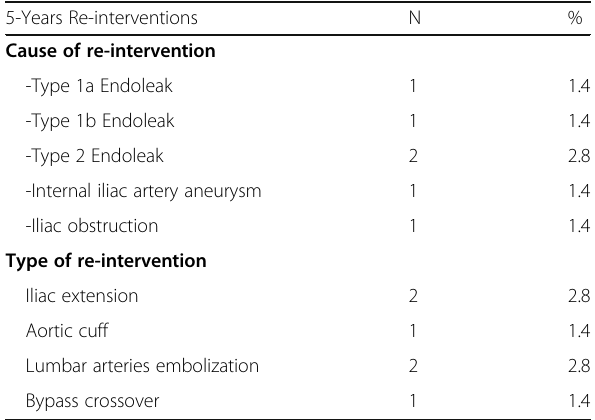
Table 5 5-years re-interventions